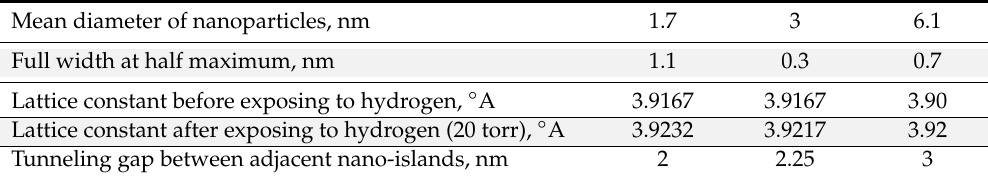
Table 1. Extracted parameters from the literature [29,39] that were used in the simulations. Mean diameter of nanoparticles, nm 1.7 3 6.1 Full width at half maximum, nm 1.1 0.3 0.7 Lattice constant before exposing to hydrogen, ◦ A 3.9167 3.9167 3.90 3.9232 3.9217 3.92 2 2.25 3